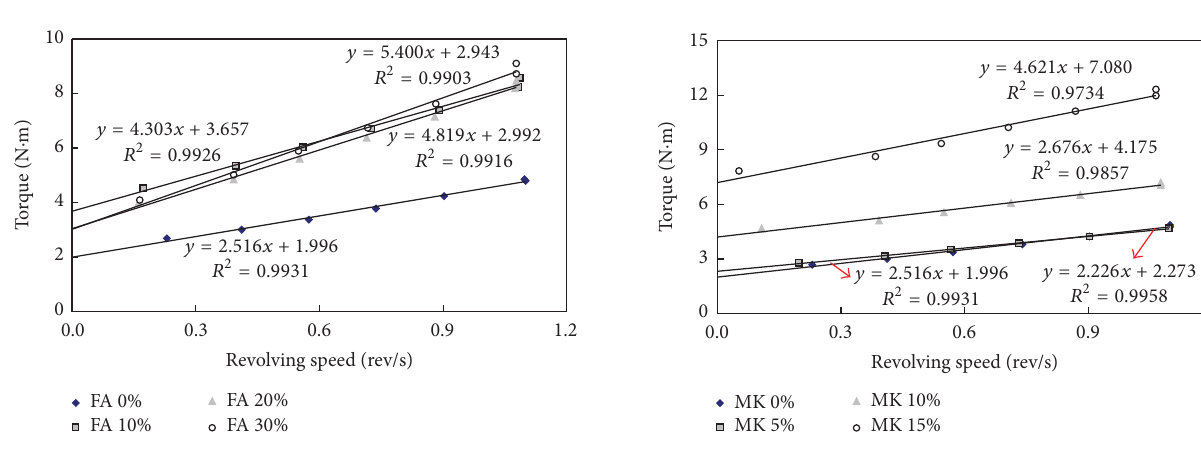
Figure 8: Exerted torque versus rotational speed relationship for metakaolin mixtures with 9.1% silica